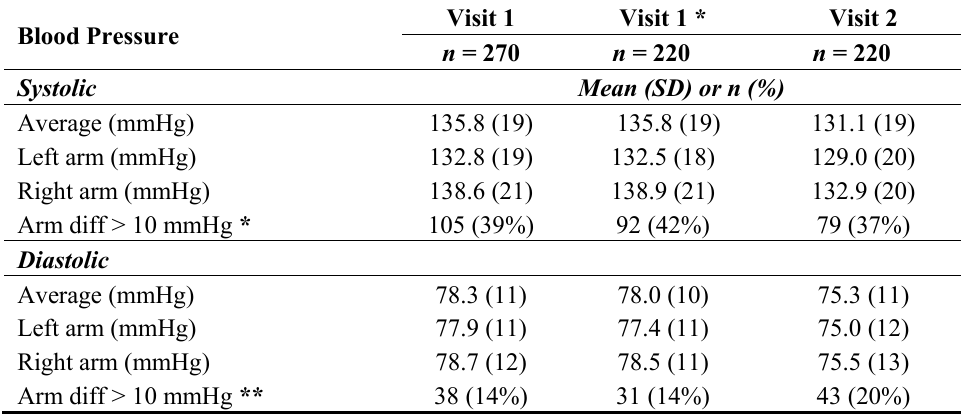
Table 2. Systolic and diastolic blood pressure measurement during clinic visit 1 and who had a second